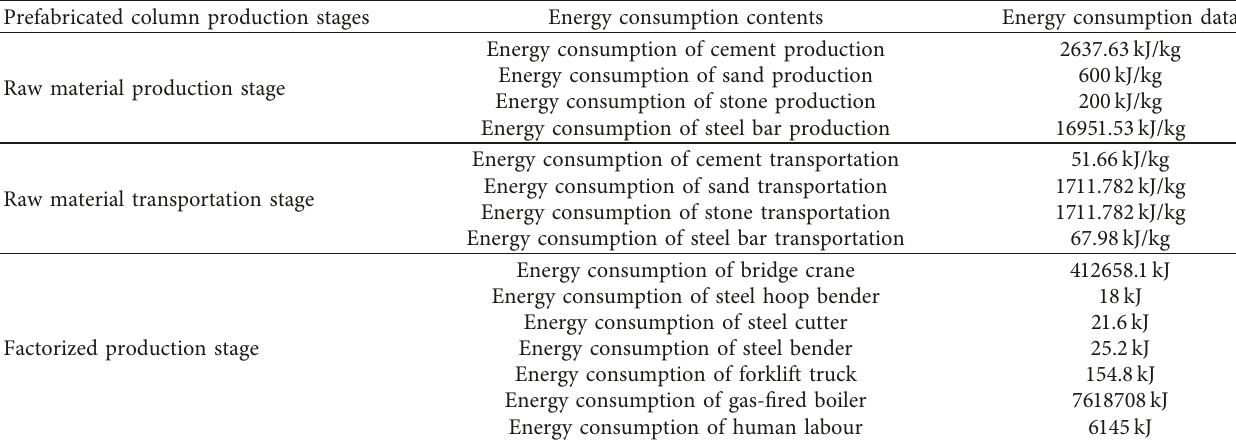
Table 11: Energy consumption inventory of prefabricated column